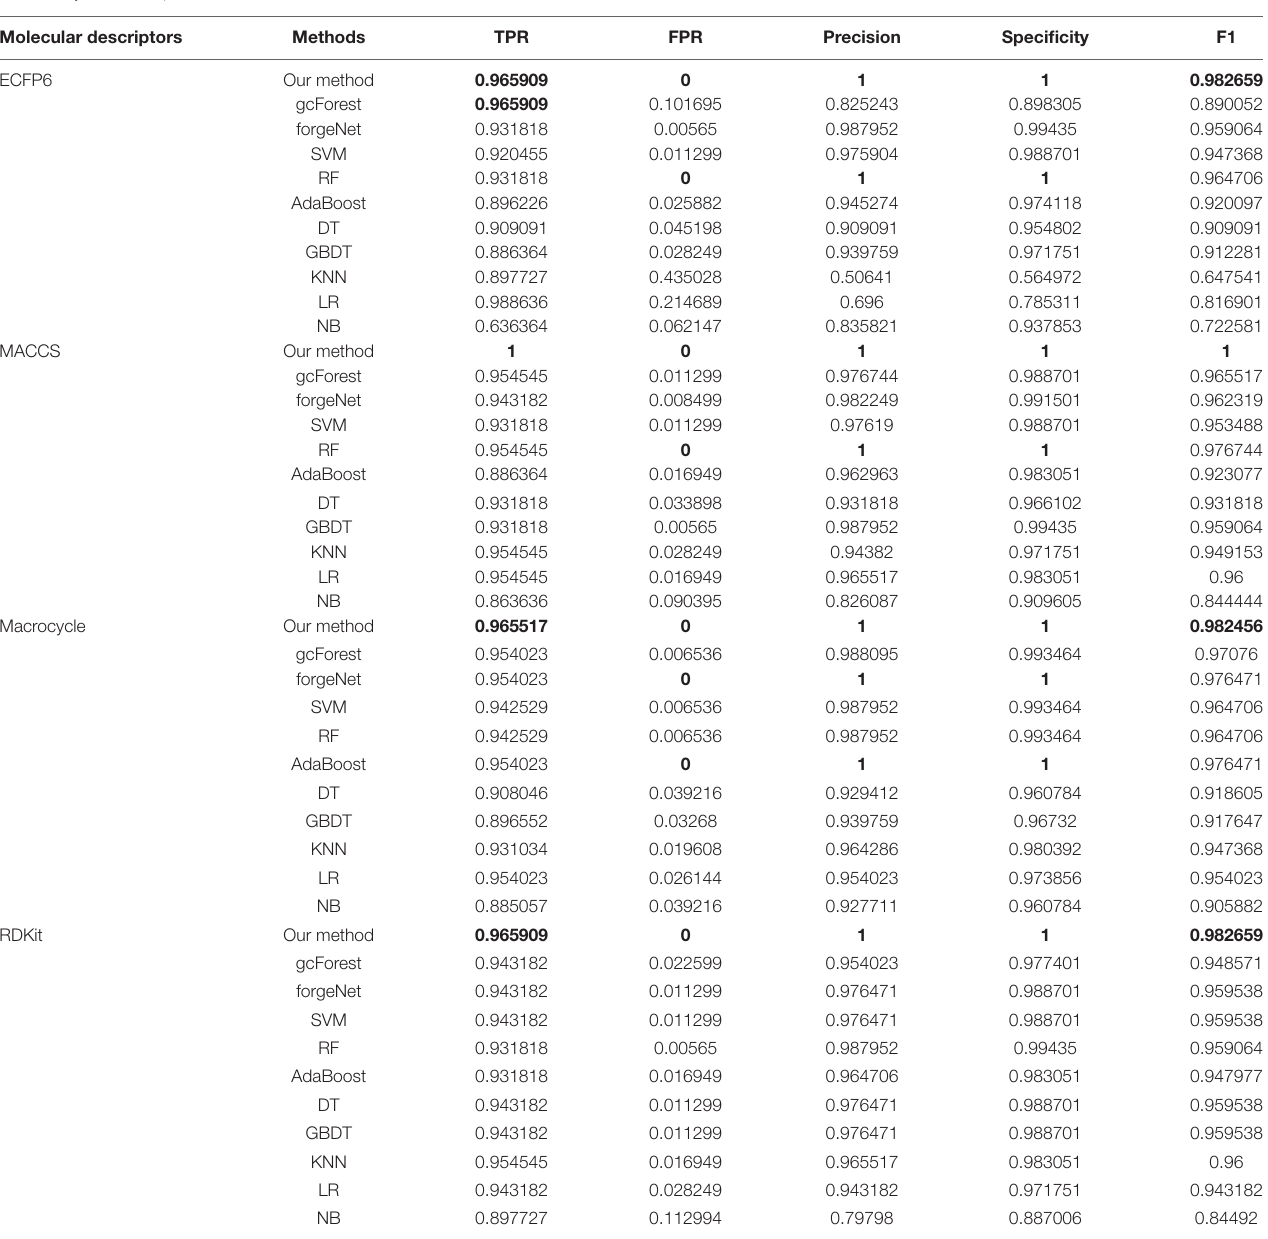
TABLE 3 | Prediction performances of 11 methods with COVID-19